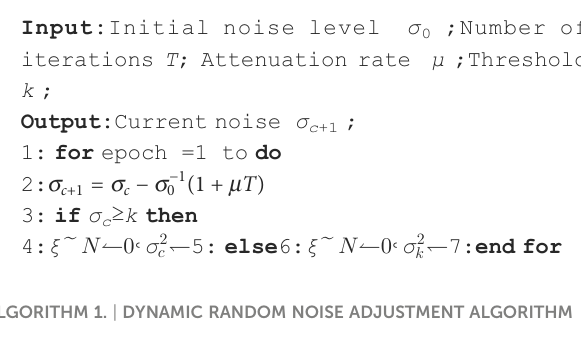
ALGORITHM 1. | DYNAMIC RANDOM NOISE ADJUSTMENT